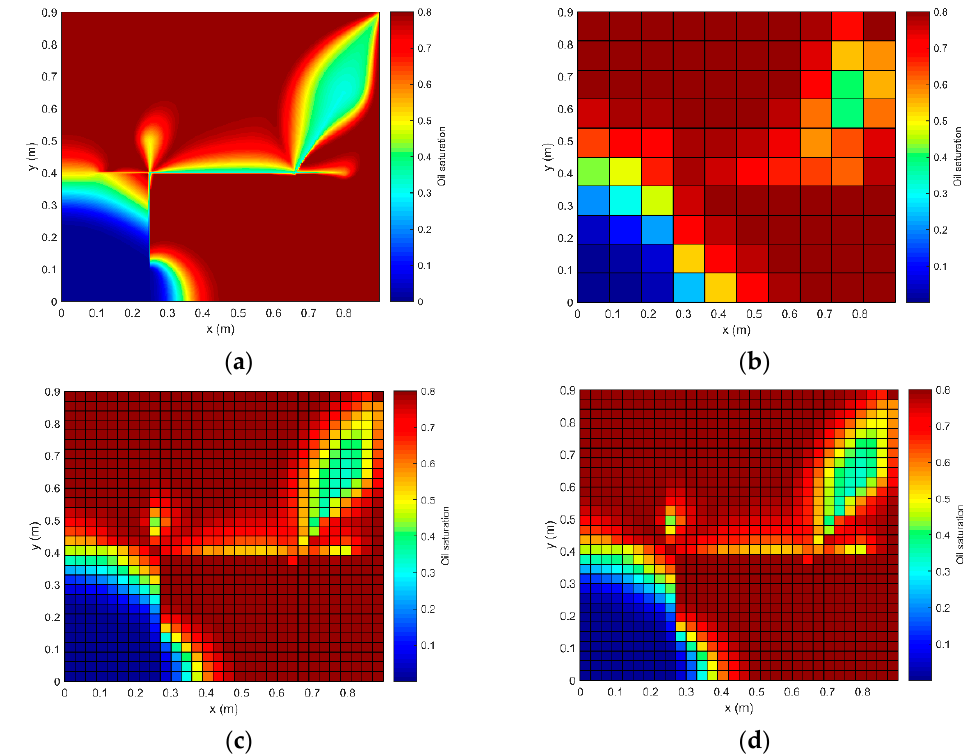
Figure 9. Profiles of oil saturation after 115 days’ injection for Case 2 in: ( a ) the fine-grid model; ( b ) iEDFM (10 × 10, gridding method I); ( c ) iEDFM (30 × 30, gridding method I); and ( d ) iEDFM (30 × 30, gridding method II).